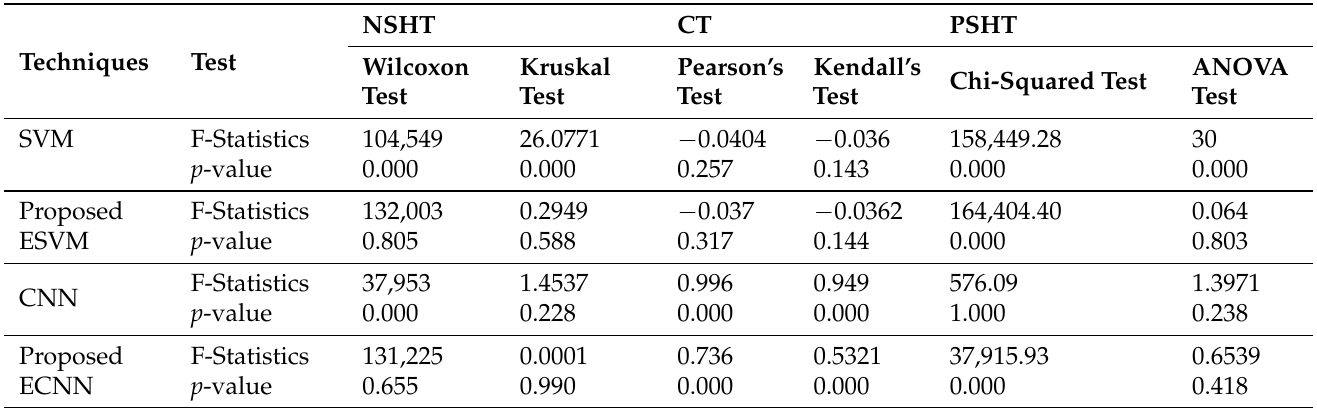
Table 4. Statistical analysis tests for proposed techniques and conventional techniques. Note: PSHT: Parametric statistical hypothesis tests; CT: Correlation test; NSHT: Nonparametric statistical hypothe- sis